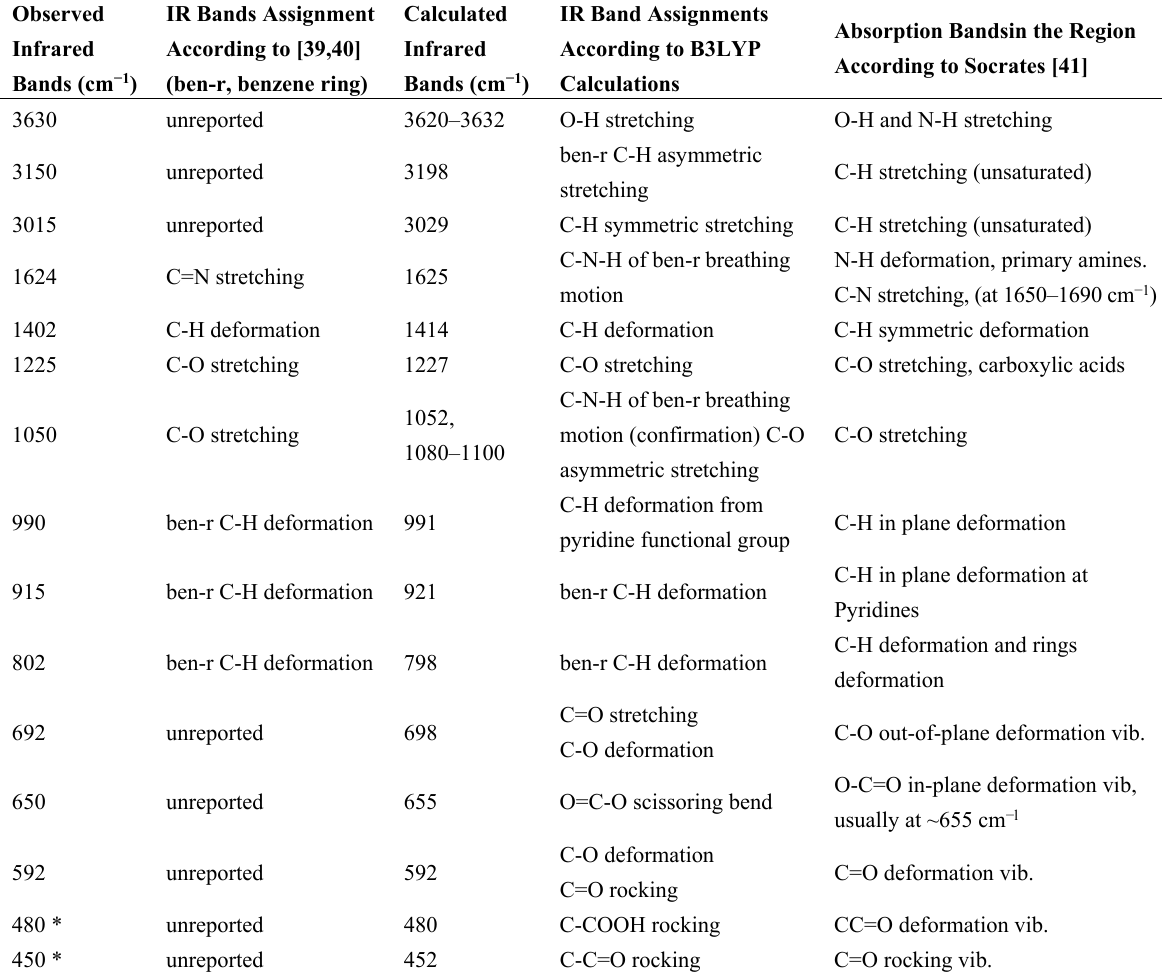
Table 3. FTIR Assignment of the Most Important Bands Observed in the Beta vulgaris spectra. Observed